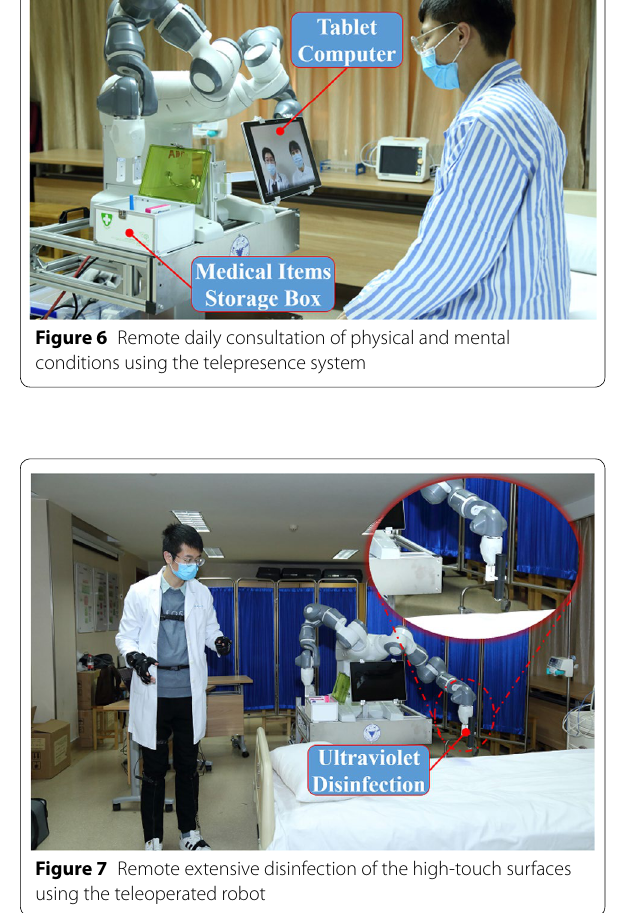
from healthcare workers for its potential in blocking infection and effectiveness in relieving medical workers from repeated tasks. In addition, this teleoperated robot also has potentials in other areas like space exploration, bomb disposal, disaster rescue and any other fields with a need of remote operation.